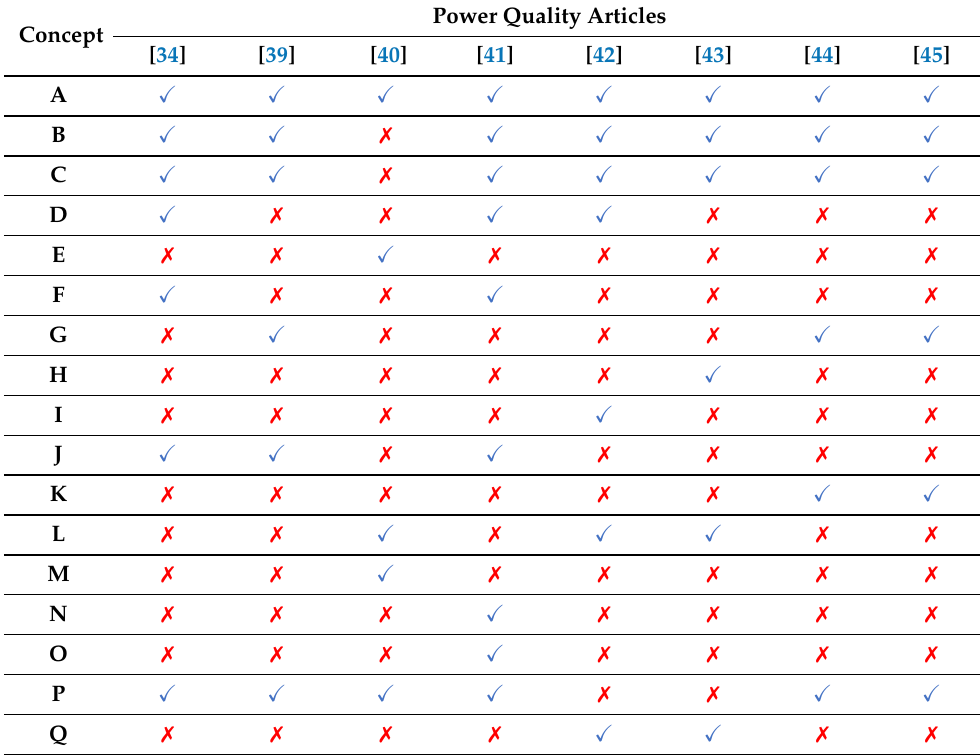
Table 1. Summary of the recently published secondary control for power-quality